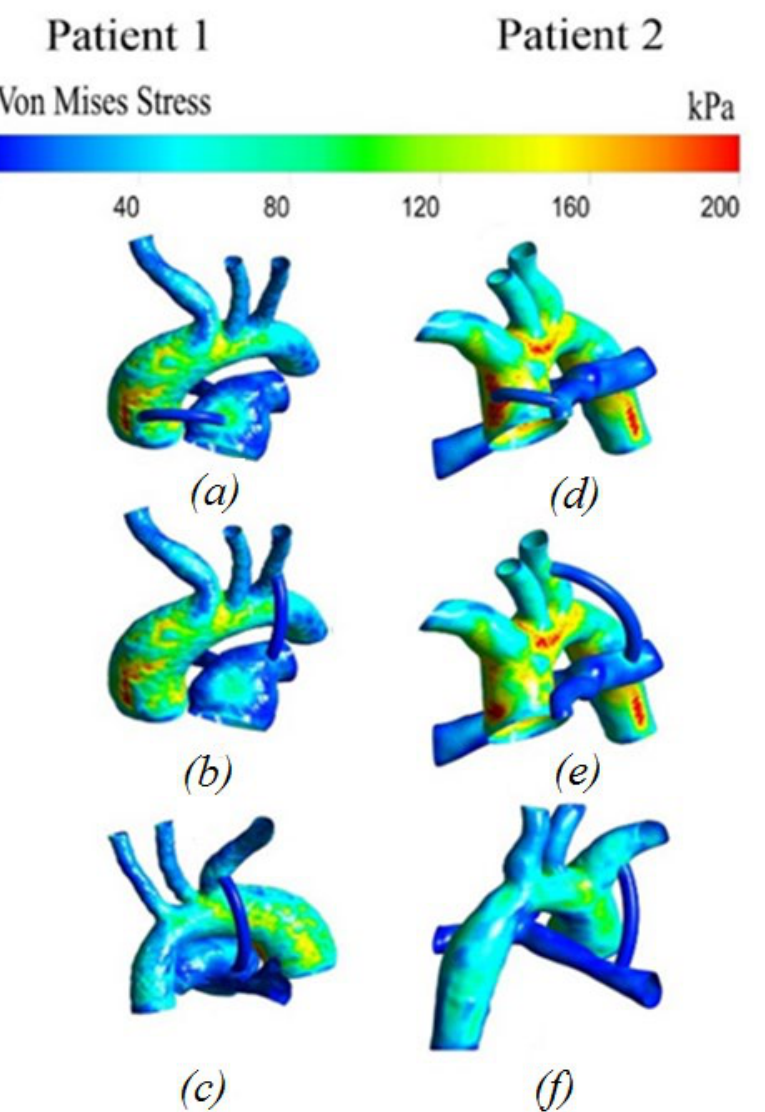
Figure 11. Distribution of stresses in the case of anisotropic properties of the aorta and hyperelastic properties of the shunt: ( a , d ) central shunt; ( b , e ) right shunt; ( c , f ) left shunt.